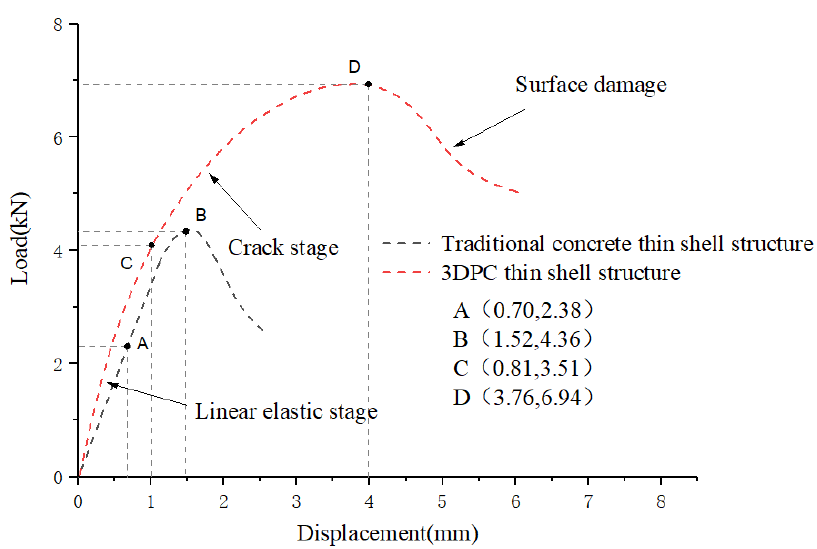
Figure 7. Load-displacement curve of the two thin-shell structures.